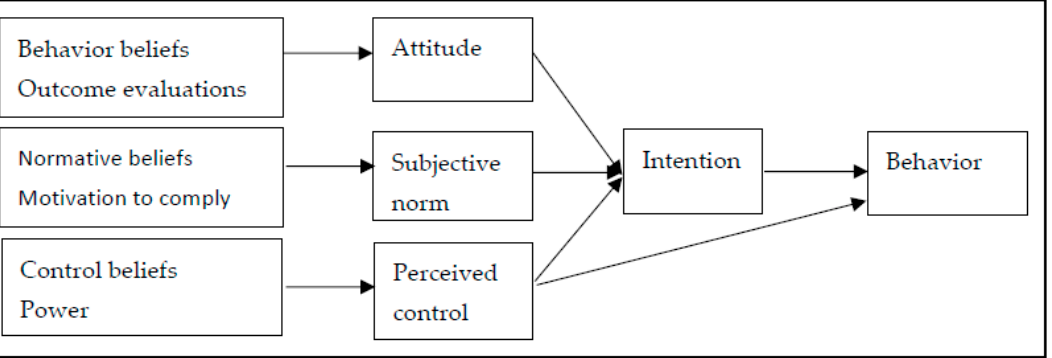
Figure 6. A representation of the Theory of Planned Behaviour. Based on Ajzen [11].